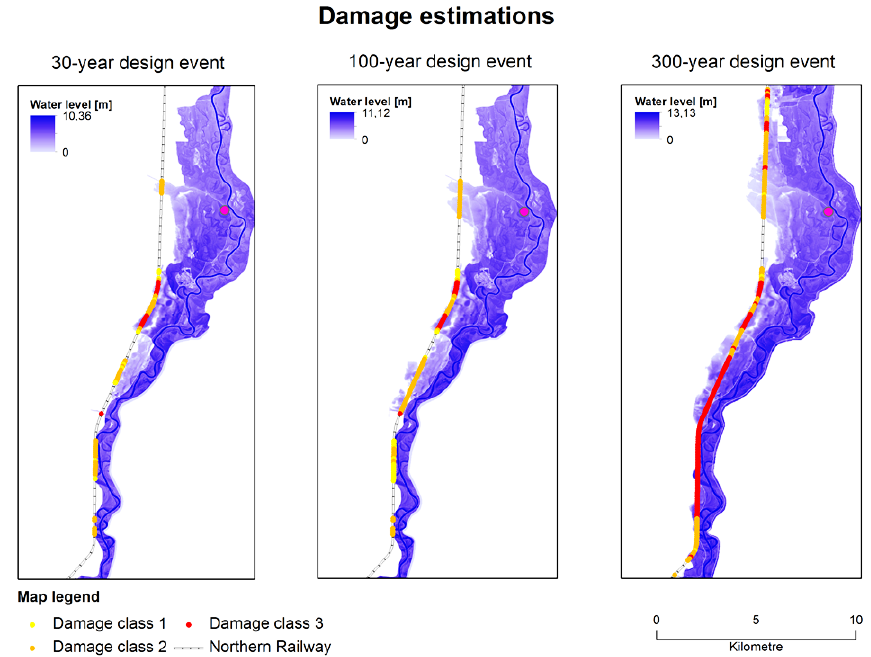
Figure 6. Estimation of damage potentials at the Northern Railway for three flood scenarios. The left map shows the model results for the hydraulic input of a synthetic 30-year event. The results for a synthetic 100-year event are illustrated in the middle map. The right map covers the results of the model application with the hydraulic input of a 300-year design event. In contrast to the hydraulic input of the March flood in 2006, the three levee breaches were not considered in these design events. Instead, a levee breach scenario at the March tributary Zaya was included (see pink dot). Hence, although the March River flood in 2006 was classified as a 100-year event, significant differences to the synthetic 100-year event can be identified (e.g. inundation area, local water levels).